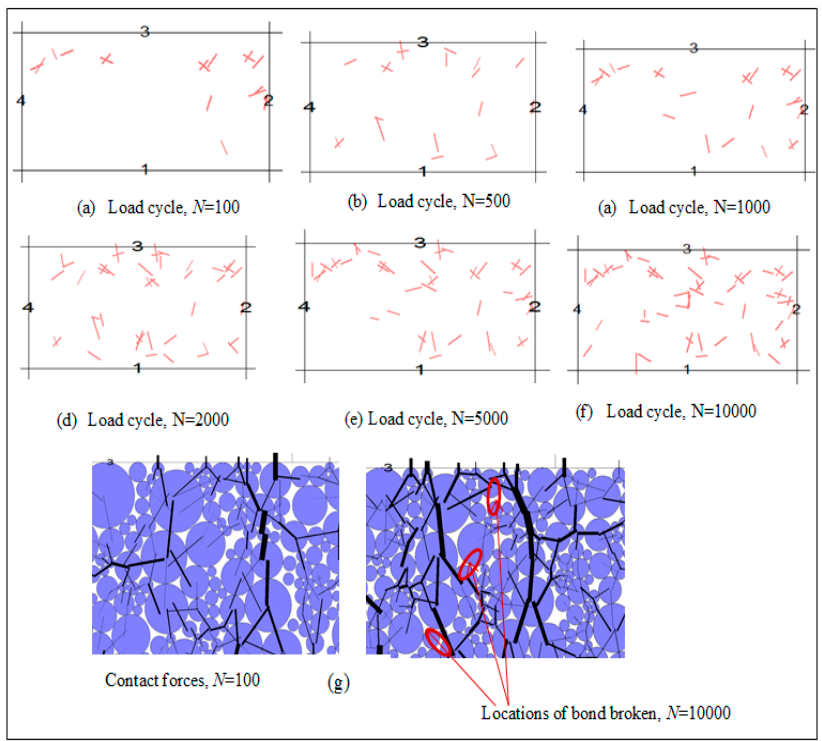
Figure 18. Predicted bond breakage at varied load cycles: ( a ) N = 100; ( b ) N = 500; ( c ) N = 1000; ( d ) N = 2000; ( e ) N = 5000; ( f ) N = 10000 (data source: Ngo et al. [62]—with permission from ASCE); ( g ) contact forces, N = 100